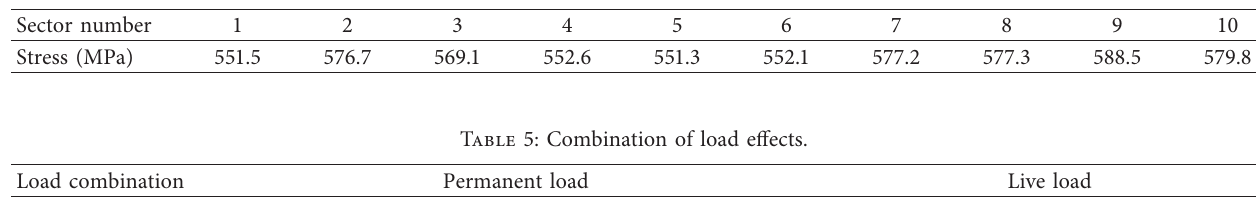
Figure 10: Tensile stress in sector 9 under 100 traffic load modes. Table 4: Traffic load effects.